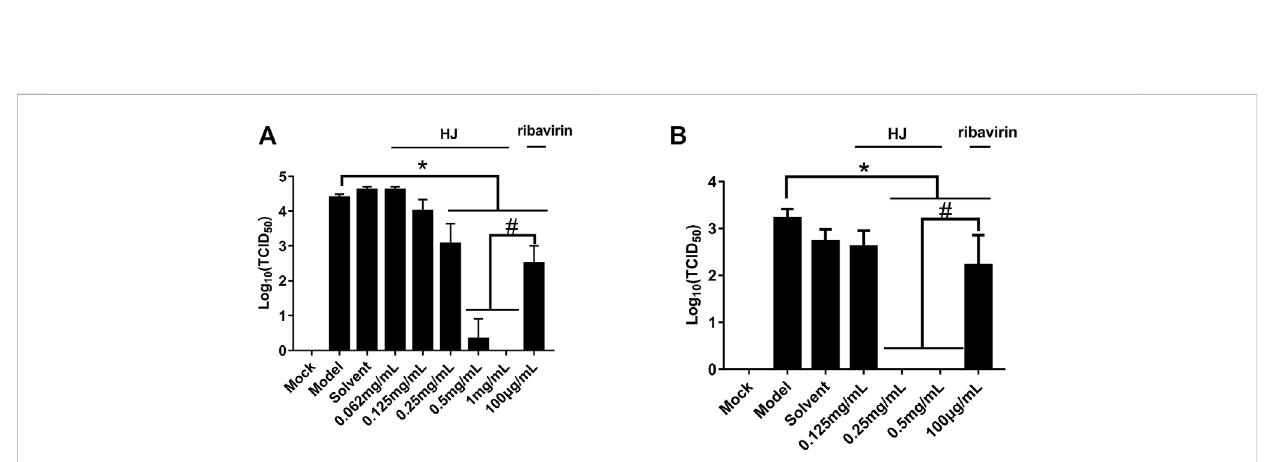
FIGURE 4 The viral titers of PEDV-CV777 (A) and PEDV-G2 (B) were determined by measuring TCID 50 with theend-point dilution methods. Cells weretreated with HJ throughout the experiment, and samples were harvested for 24 h. Data are represented as mean ± SD, n = 3. *, and p < 0.05 was considered statistically signi fi cant compared with the model group, while # , and p < 0.05 was considered statistically signi fi cant compared with ribavirin